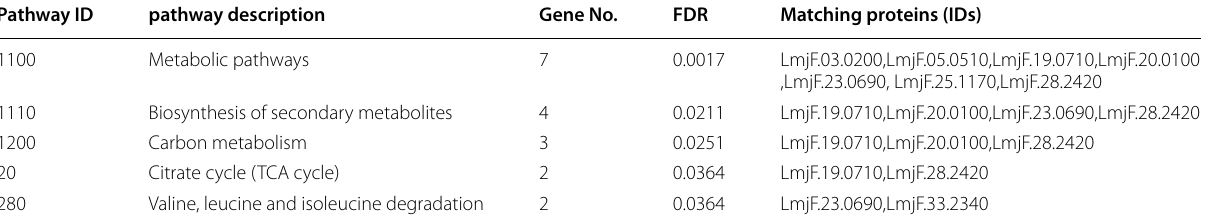
FDR false discovery rate, KEGG kyoto encyclopedia of genes and genomes